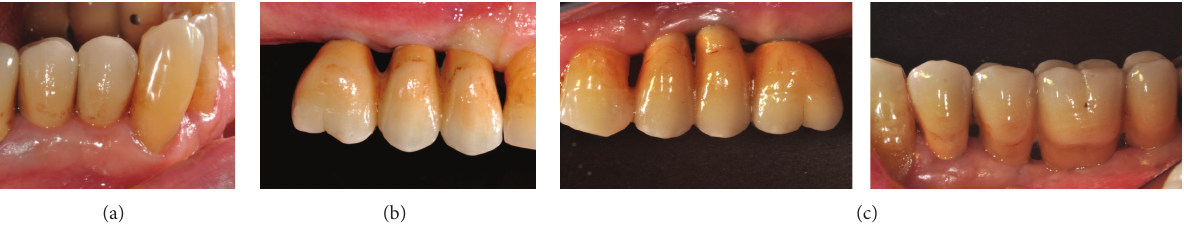
Figure 8: Clinical situation at the delivery of prosthetic rehabilitation: (a) type 1 implant positioning; (b) type 2 implant positioning; (c) type 3 implant positioning.